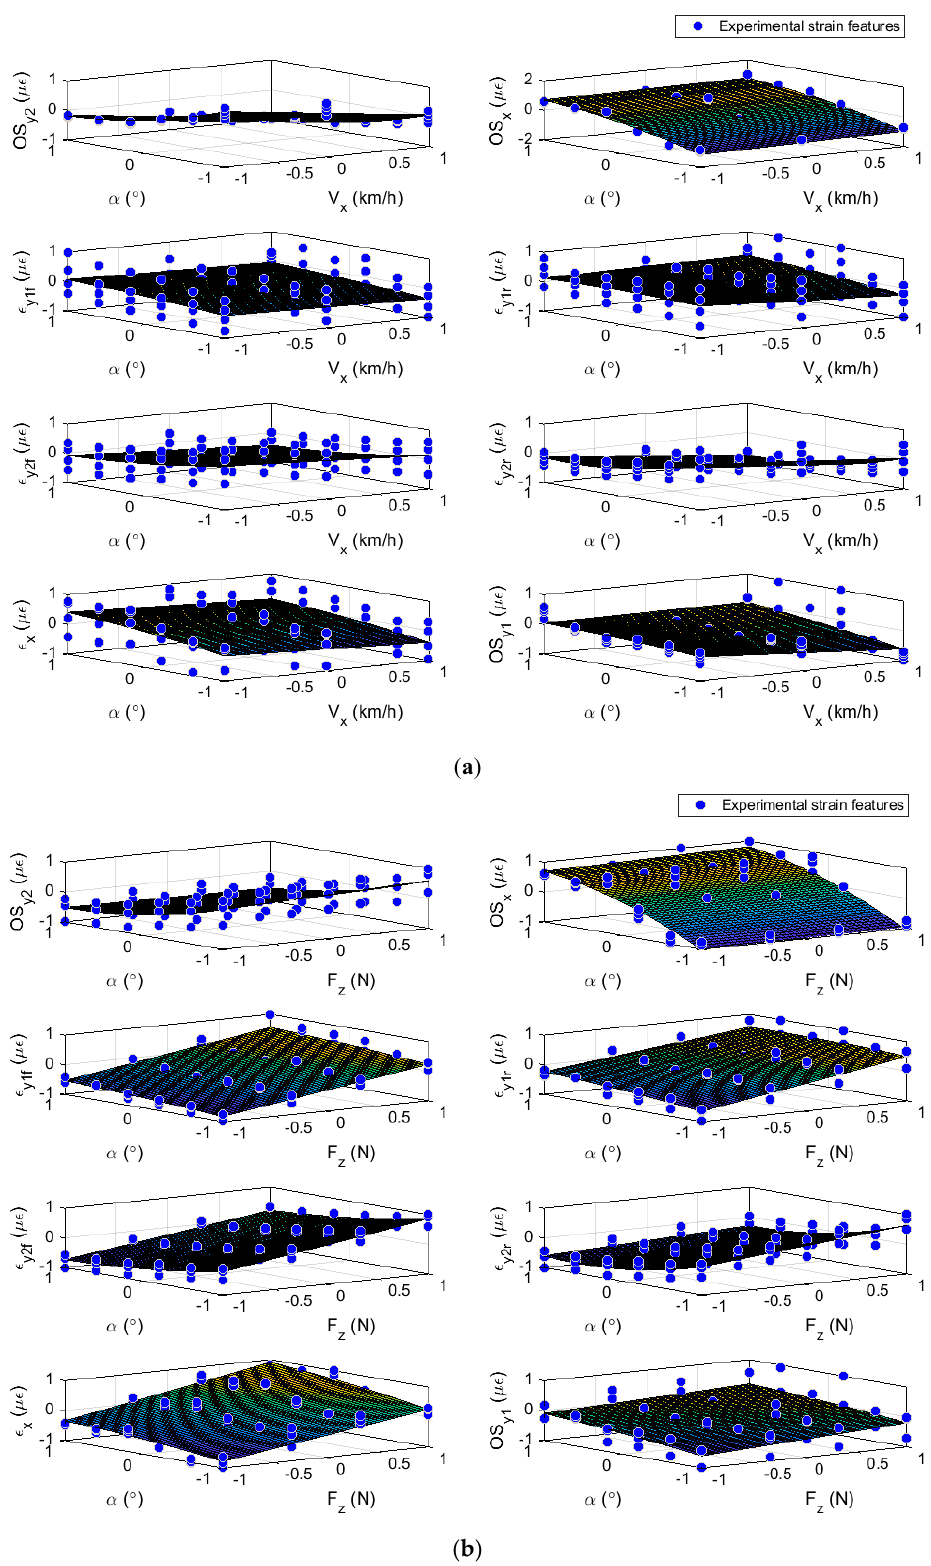
Figure 7. Curve surface fitting, variation of the strains features as function of potential parameters. ( a ) Strain features as function of slip angle and rolling speed. ( b ) Strain features as function of slip angle and vertical load.